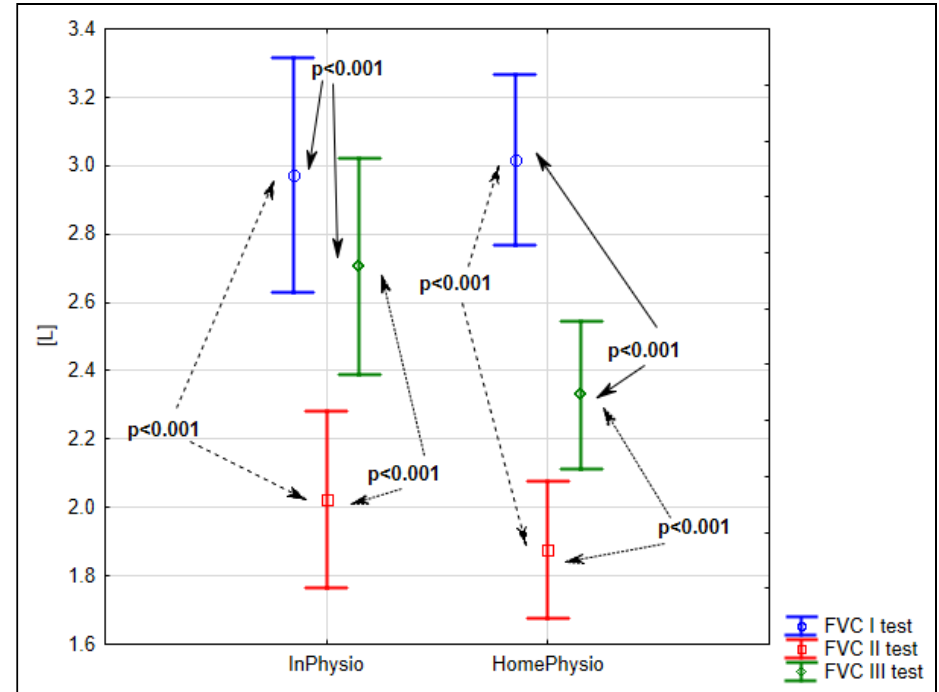
Figure 1. Evaluation of mean FVC before surgery (S1), five (S2) and 25–30 days after surgery (S3) in the InPhysio and HomePhysio groups. InPhysio and HomePhysio